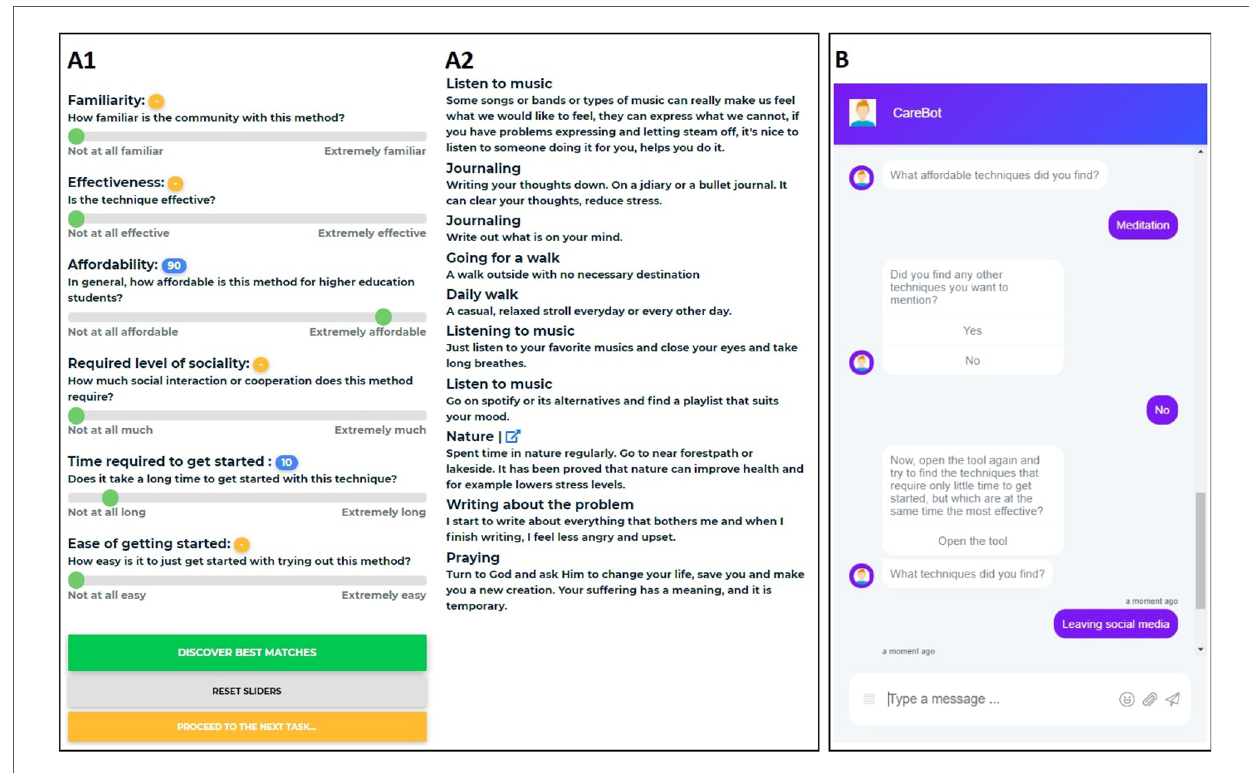
FIGURE 1 Snippets of our two platforms used in the study. ( A ) The system for mental health self-care discovery with sliders for different criteria ( A1 ) and recommended methods ( A2 ), based on the slider selections. ( B ) The chatbot with examples of asking found methods and presenting the user with a new